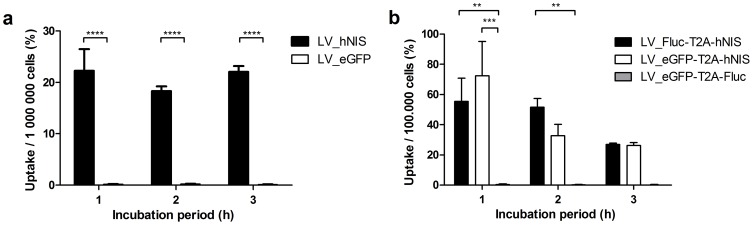
Results of uptake experiments with 99mTcO4
− in HEK293T cells after the induction of hNIS expression.Uptake ratios resulting from the transduction with a unicistronic LV (b) and a bicistronic LV (c). Significantly higher uptakes were observed in cells expressing hNIS. **: p<0.01; ***: p<0.001; ****:p<0.0001.